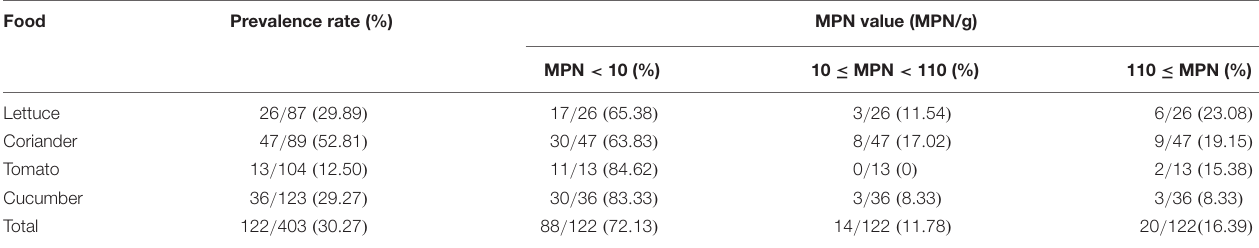
TABLE 1 | Prevalence and level of Cronobacter spp. in different foods. Food